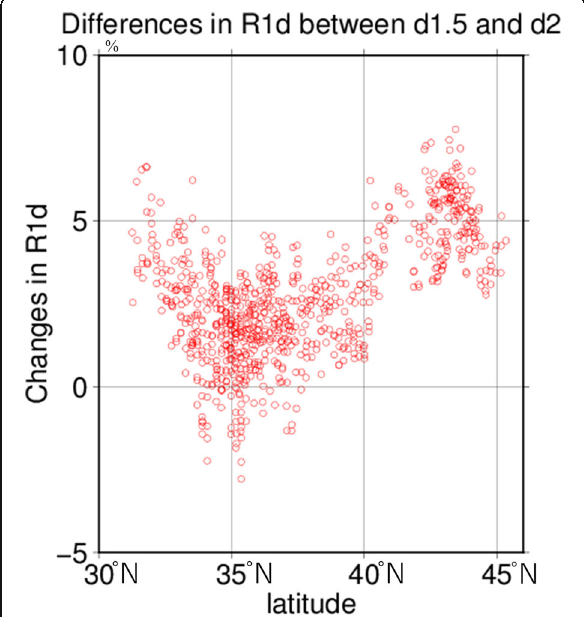
Fig. 10 Differences in R1d (%) between d1.5 and d2 on land grids in the Japanese Islands